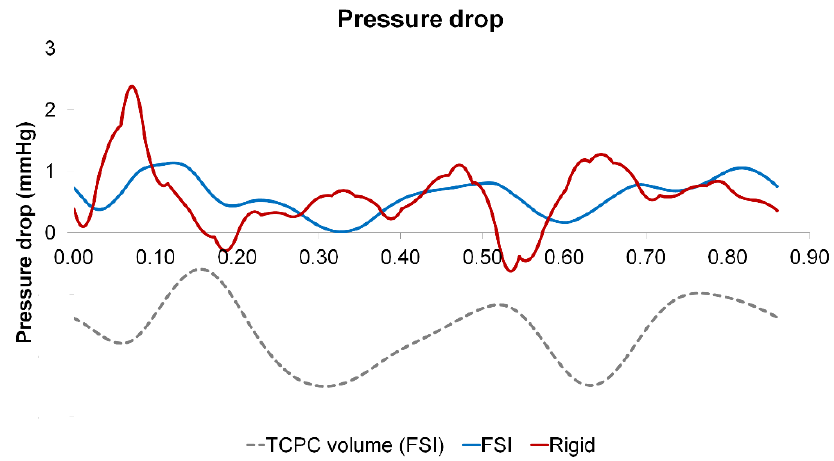
Figure 9. Pressure drop waveforms of the rigid wall and fluid-structure interaction (FSI) simulations within a cardiac cycle. The waveform of the TCPC volume from the FSI simulation is shown simultaneously. TCPC: total cavopulmonary connection.